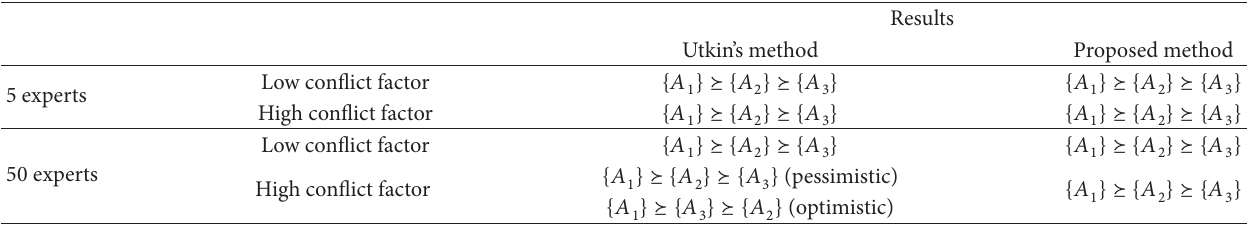
Table 8: Results of comparison between Utkin’s method and proposed